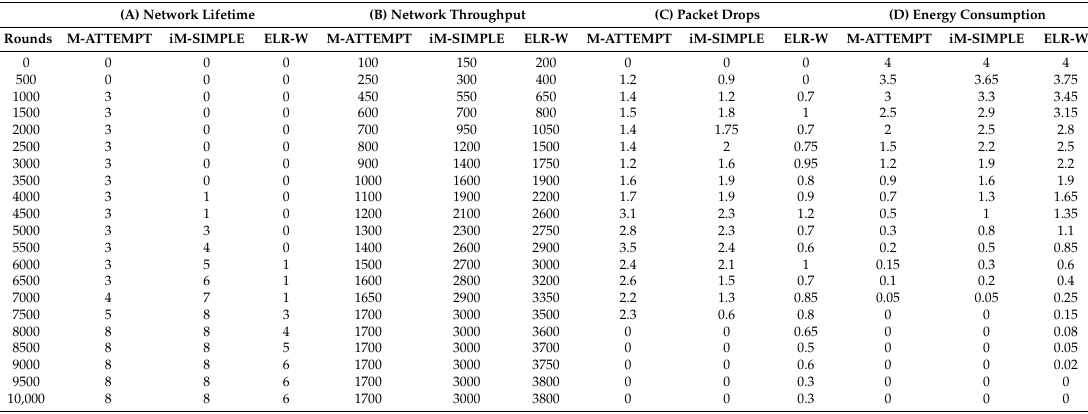
Table 3. Analysis of: (A) network lifetime; (B) network throughput; (C) packet drops; (D) energy consumption.